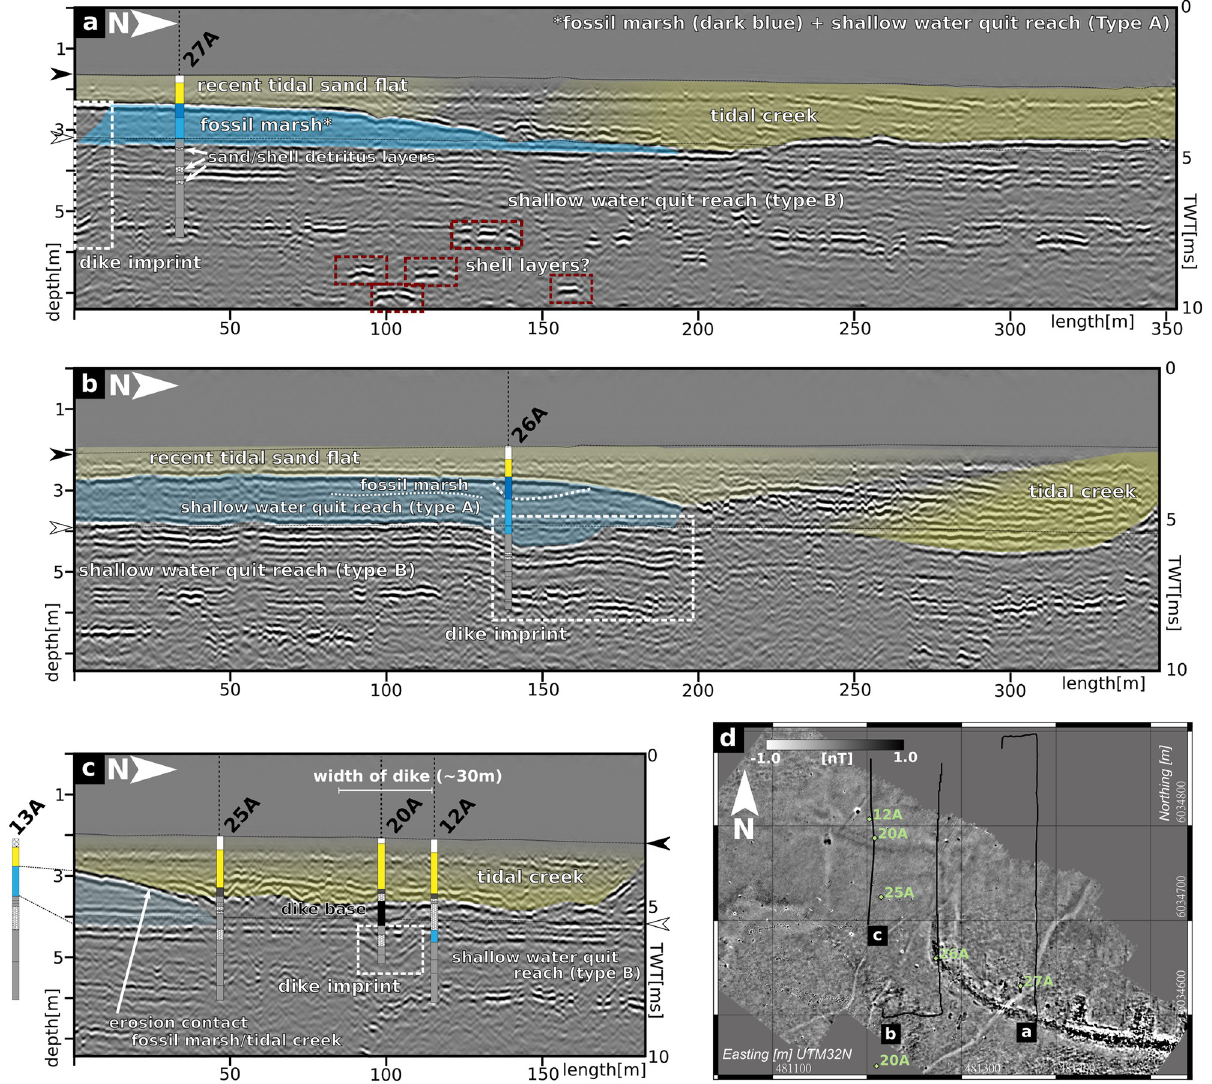
Fig 7. Seismic and coring results. a)-c) selected seismic profiles and their preliminary interpretation based on coring results, which are also indicated by coloured bars (facies colors are similar to Fig 5). The positions of the profiles and the cores are shown in the d).